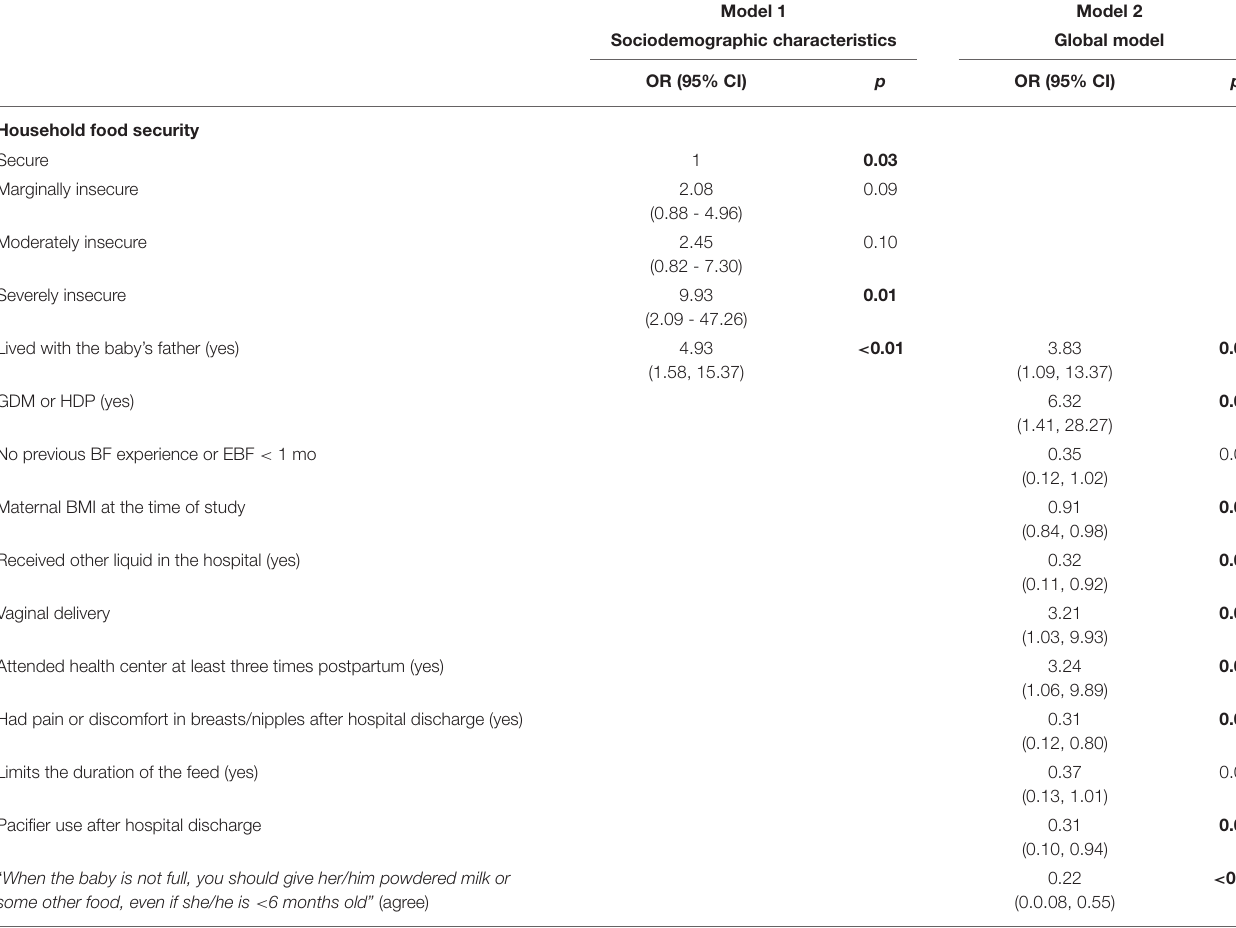
TABLE 4 | Logistic regression models for factors associated with